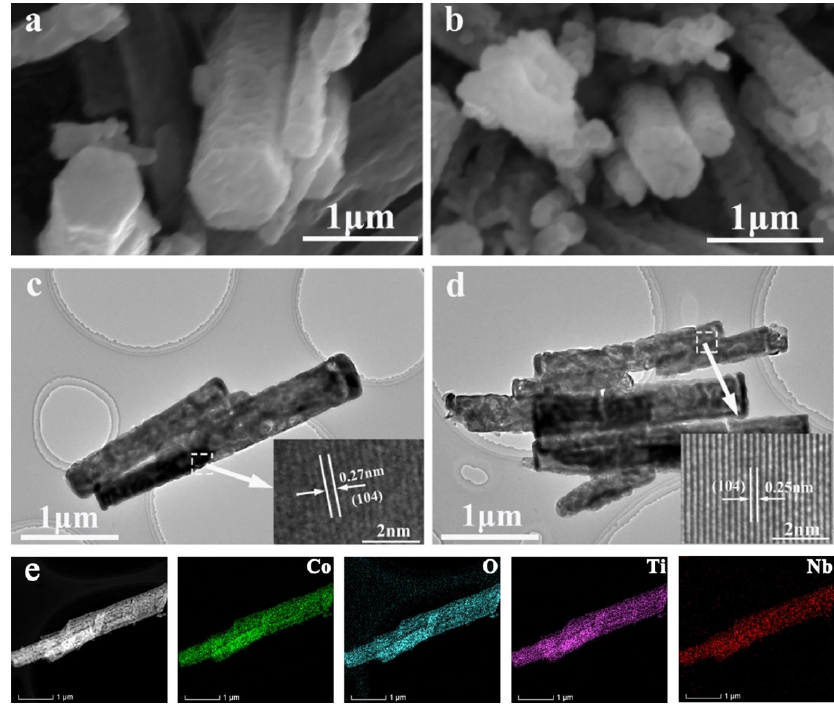
Figure 3. SEM images of ( a ) S0 and ( b ) S1 and TEM images of ( c ) S0 and ( d ) S1. ( e ) HAADF-STEM image of S1 and the corresponding EDX elemental mappings of Co, O, Ti, and Nb. XPS measurement was conducted to investigate the chemical bonding states of the samples. The full spectrum of S1 (Figure S3) demonstrates the occurrence of elements of Co, Nb, Ti, and O. For Co 2p high-resolution XPS (Figure 4a), two broad peaks occur at 781.3 and 797.2 eV accompanied by two satellite peaks that correspond to Co 2p 3/2 and Co 2p 1/2 , respectively, confirming the existence of divalent cobalt ions [37]. As for the Ti 2p spectrum (Figure 4b), the two distinct peaks located at 458.2 and 463.9 eV stem from typical Ti 4+ 2p 3/2 and Ti 4+ 2p 1/2 , respectively [38]. In addition, as for the O 1s spectrum (Figure 4c), there are two peaks centered at 530.0 and 530.8 eV that can be assigned to the